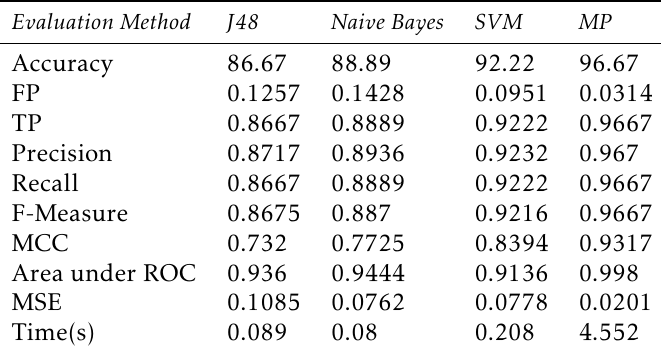
Table 9. Evaluation of Machine Learning Models